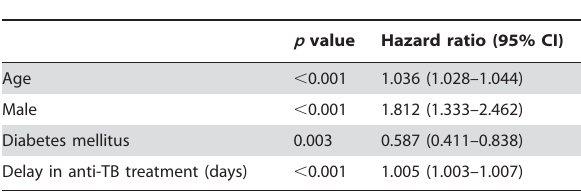
Table 5. Independent risk factors for developing COPD in pulmonary tuberculosis (TB) patients (n =3176), by Cox proportional hazards regression